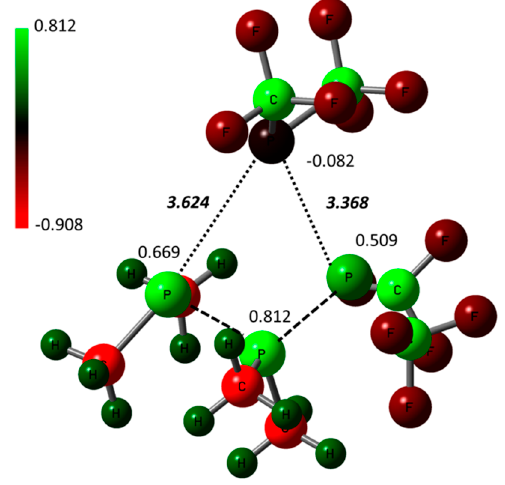
Figure 3. Natural Atomic Charges corresponding to the intermediate Min_1. P–P bond distances are labelled in bold (in Å).